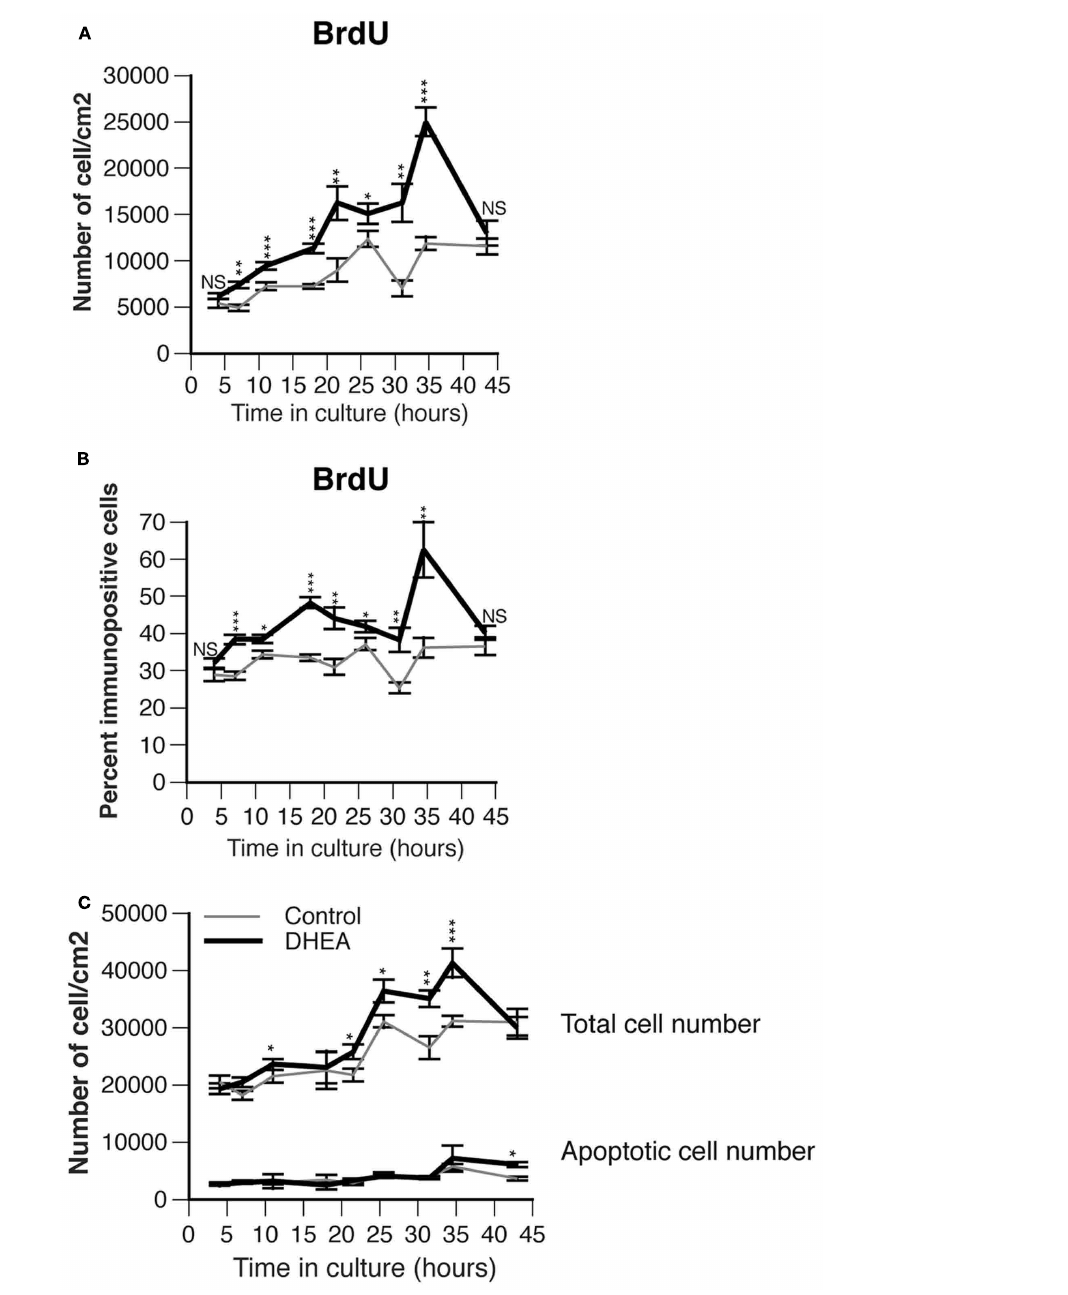
FIGURE 3 | Effect of DHEA on proliferation of precursor cells isolated from E10.5 mouse neural tube lumbar region in primary culture. (A) Number of immunopositive cells for BrdU. Cells were incubated for different period of time in the absence (control, gray line) or presence of 10 − 10 M DHEA (black line) and immunostained for BrdU. Average values are expressed as a variable of time in vitro , error bars delineate the SEM. A multiple analysis of variance (MANOVA) was performed to assess the percent variance explained by the time in culture versus that explained by the presence of DHEA in the culture medium. Differences between groups for each of these factors were determined by using one-way ANOVA and Bonferroni’s post hoc test. Asterisks show significant differences between control and DHEA-treated